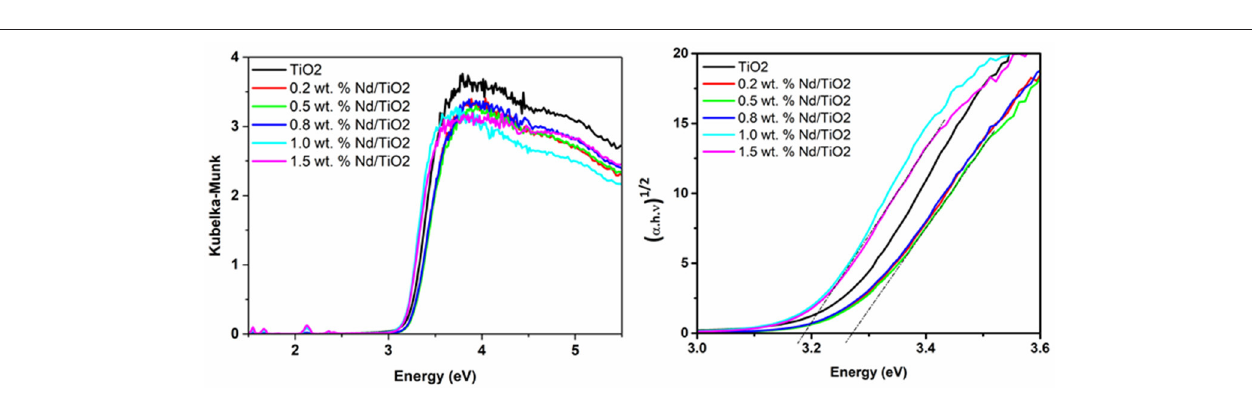
content of brookite increases from 6.6 (pure titania) to